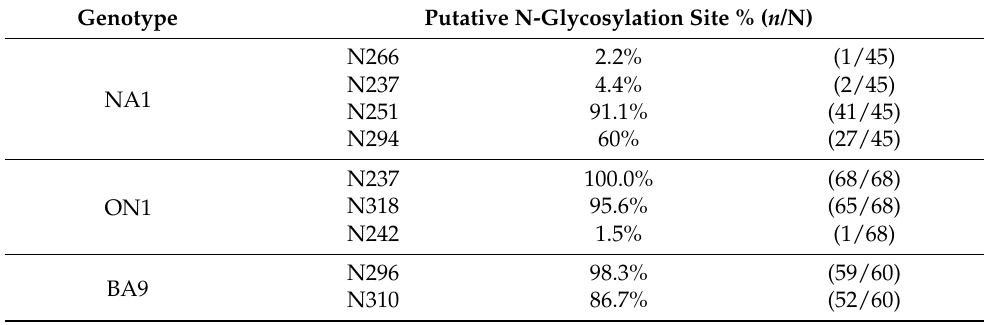
Table 3. Putative N-glycosylation sites of the RSV genotypes NA1, ON1, and BA9 in Taiwan.